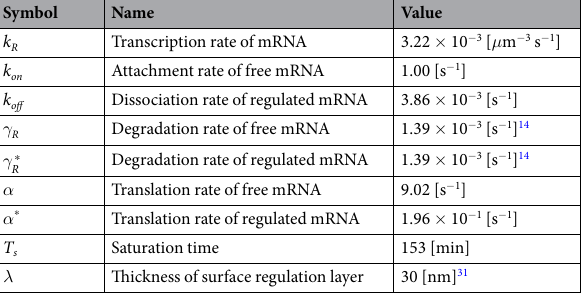
Table 1. List of parameters used for model fitting (blue solid curve) in Fig.